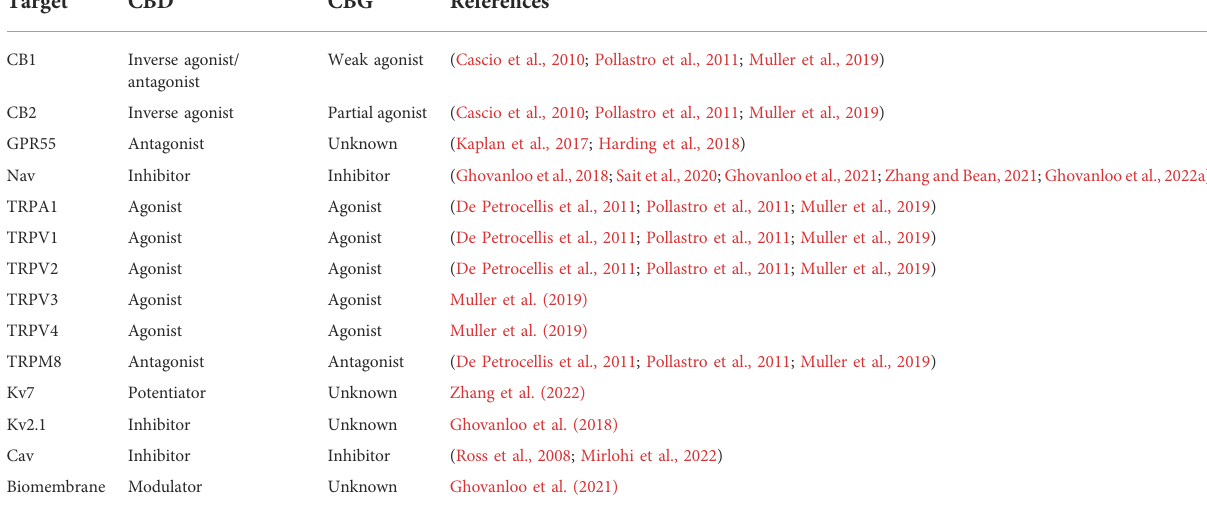
TABLE 1 Comparison of a list of key receptors and ion channel targets between CBD and CBG. See (Almeida and Devi, 2020; Ghovanloo and Ruben, 2021; Nachnani et al., 2021) for more extensive reviews of these targets.